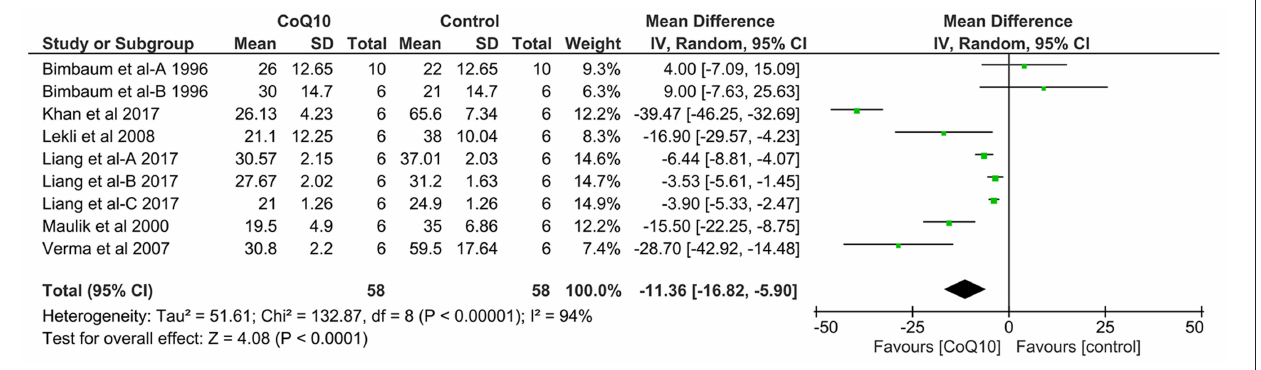
FIGURE 2 | Forest plot displaying the results of meta-analysis of coenzyme Q 10 effect on myocardial infarct size in models of myocardial ischemia-reperfusion injury compared with the control group. CI, confidence interval; df, degrees of freedom; SD, standard deviation; IV, inverse variance.